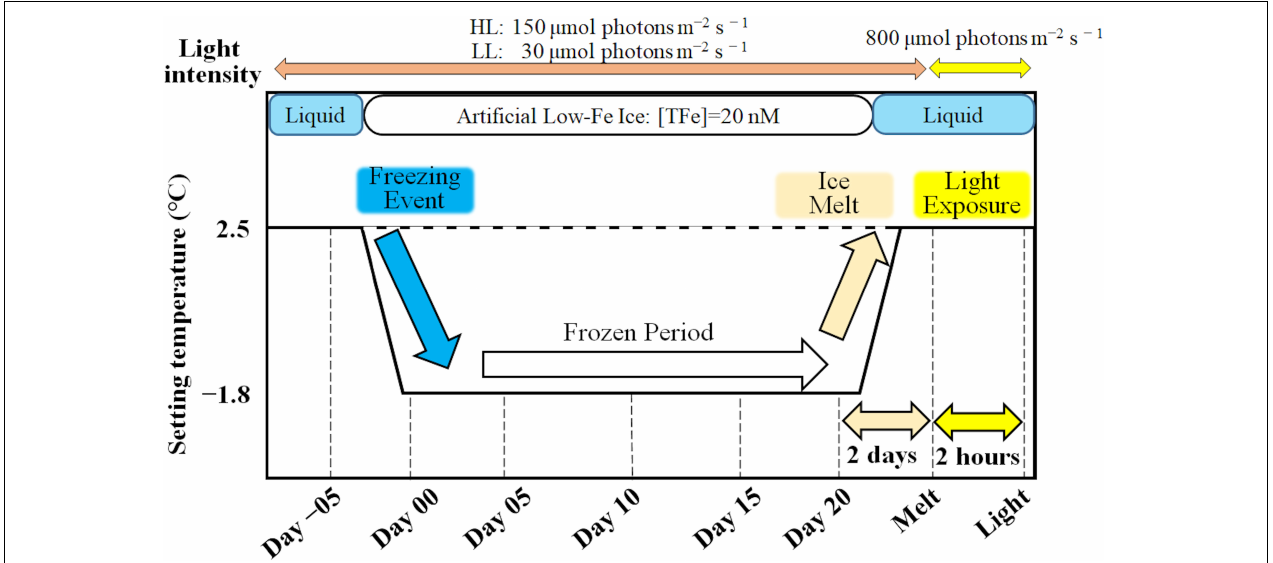
FIGURE 1 | A schematic of the ice tank incubation